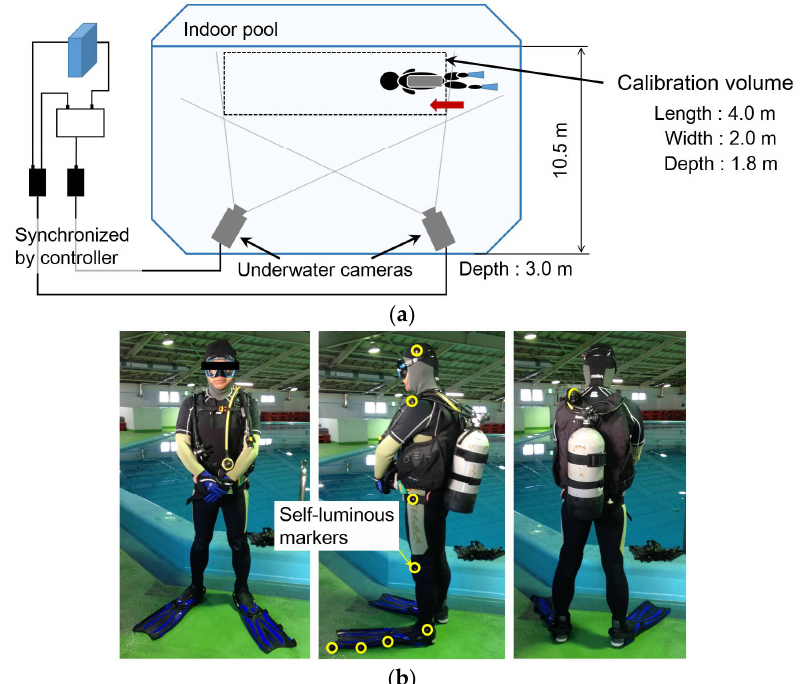
Figure 3. Schematic figure of the experimental setup and photographs of the diver: ( a ) Experimental setup; ( b ) Photographs of the